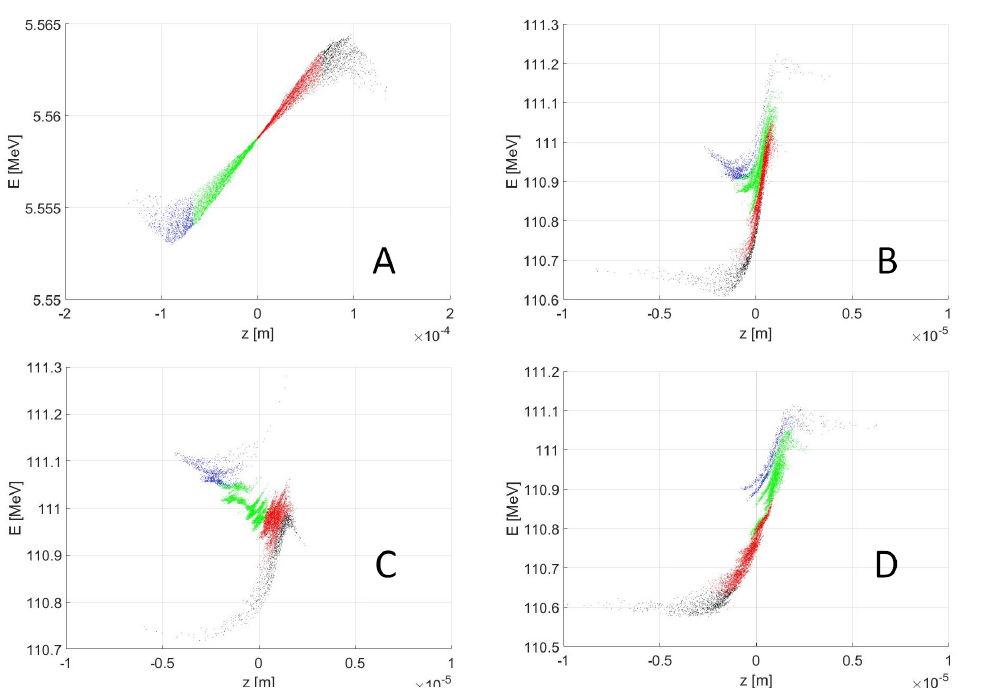
Figure 4. ( A ) longitudinal phase space of a beam at the RF gun exit. Different colors mark four longitudinal slices; ( B ) longitudinal phase space after the linac exit in the case of optimal bunch compression; ( C ) longitudinal phase space after the linac exit in the case of under-compression; ( D ) longitudinal phase space after the linac exit in the case of over-compression. The simulations have been performed using the code ASTRA